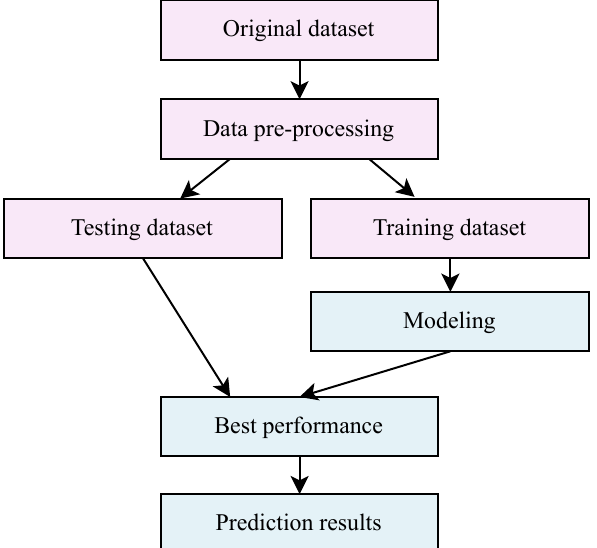
Figure 5. The global flowchart developed in this study.